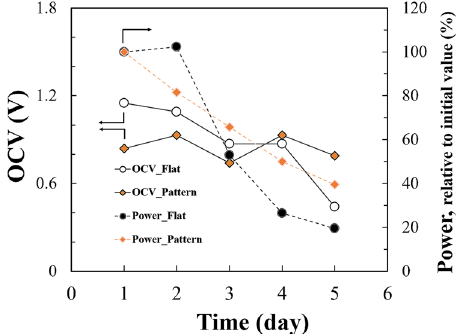
Fig. 3 Measured OCV and power (%) as functions of operation time for 5 days. The power was normalized to the initial